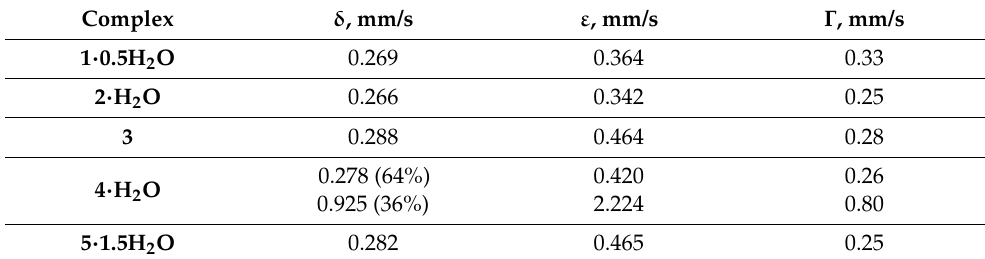
Table 5. Mössbauer spectra parameters of the complexes.